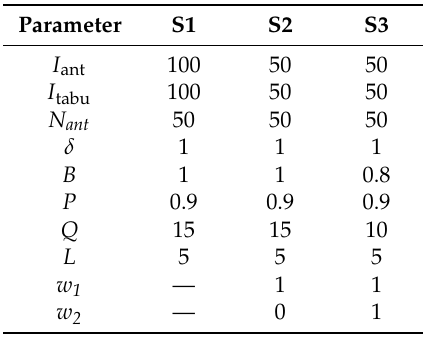
Table 5. Parameters used in the proposed